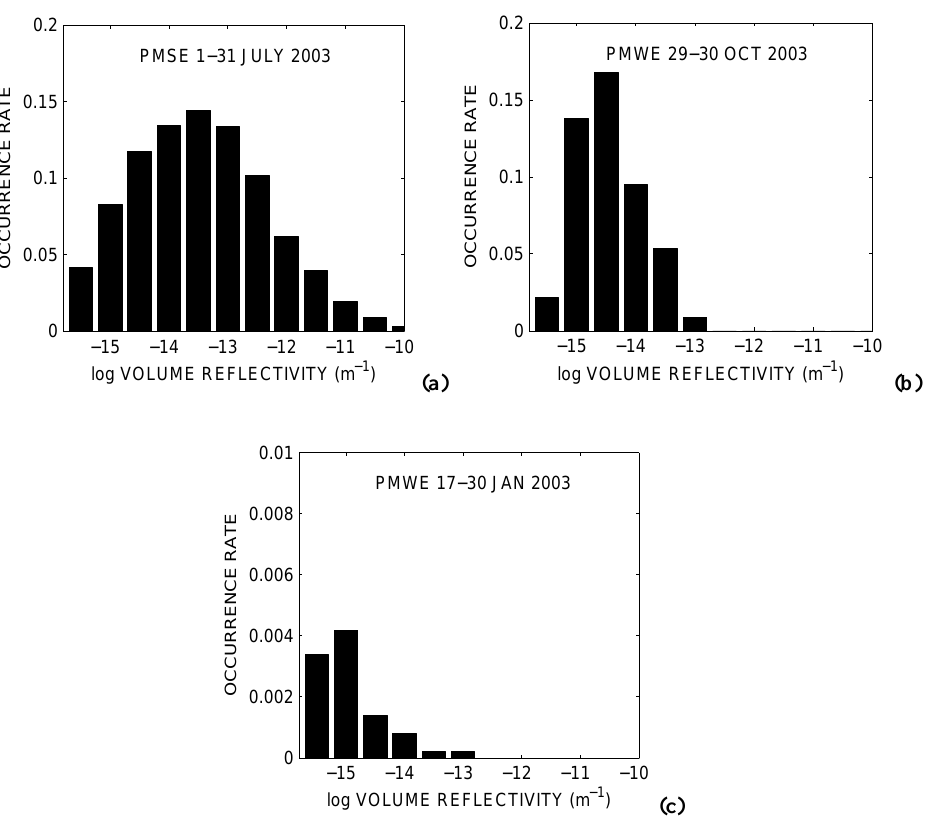
Fig. 1. Statistical analysis of the maximum volume reflectivity associated with radar echoes from the mesosphere observed by the ESRAD 52MHz radar during different conditions. Maximum volume reflectivity is the maximum observed in each 2-min averaged height profile between the heights specified below. Occurrence rate is the fraction of total time when profiles with maximum volume reflectivity in the relevant interval were observed. Top panel shows the results for summer, heights 80–90km, for the whole of July 2003. Middle panel shows the results for winter, heights 50–75km, during a major solar proton event in October 2003 (Belova et al., 2005). Lowest panel shows the results for winter, heights 50–75km, during the MacWAVE campaign in January 2003. All measurements were made with the same radar operating parameters. The derivation of volume reflectivity is as described in Stebel et al.